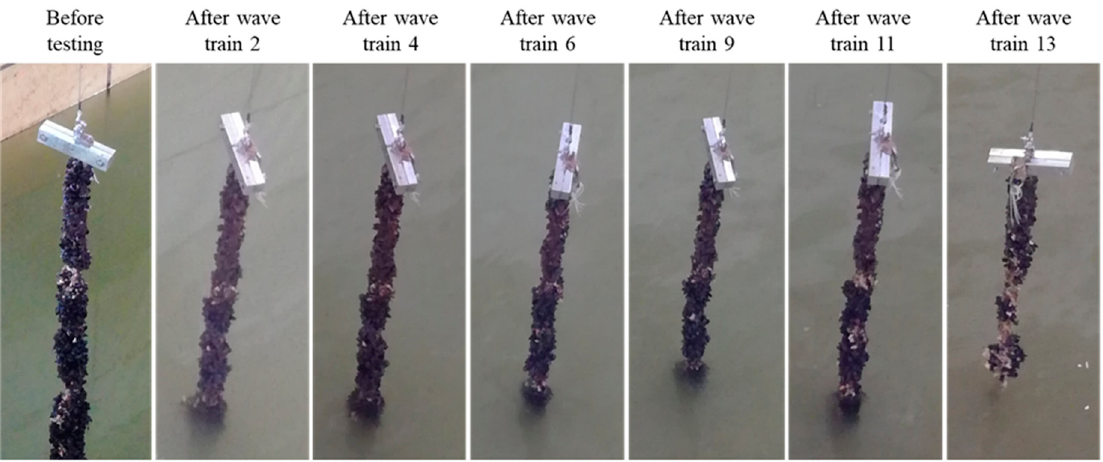
Figure 6. Mussel drop-off for line 6, depicted from before the tests to after the last test, resulting in a loss of weight of 88.1%.